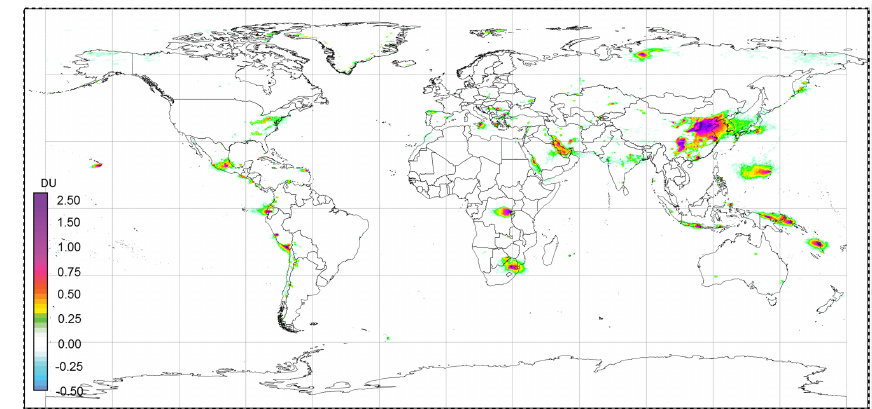
Figure 1. The global mean SO 2 distribution (in DU) map for 2005–2007. The area affected by the South Atlantic Anomaly is